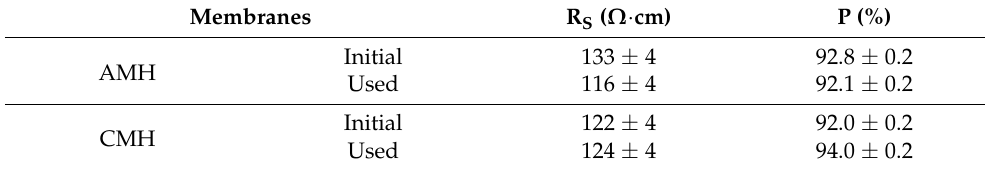
Table 4. Resistivity (R S ) and apparent permselectivity (P) of ion-exchange membranes (IEMs). Membranes